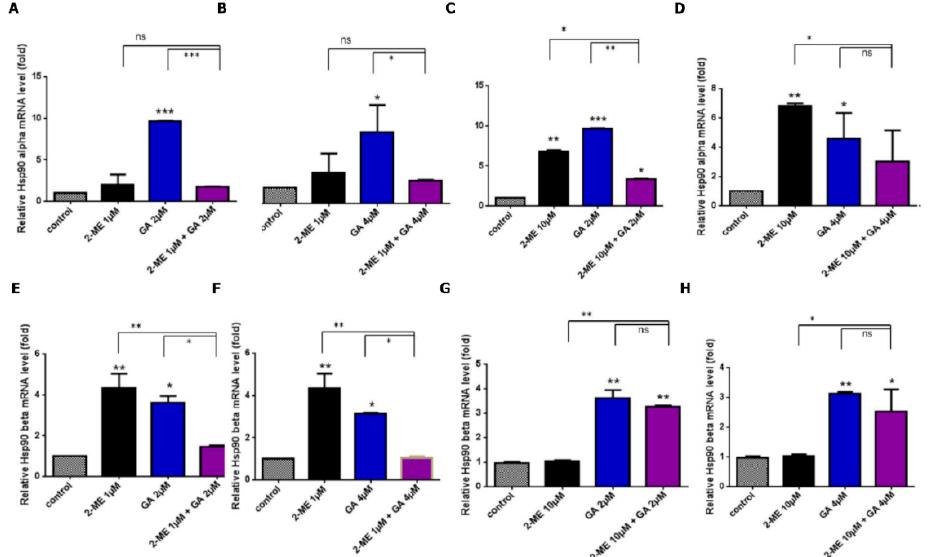
Figure 6. 2-ME and GA control the gene expression of Hsp90 alpha and Hsp90 beta in OS 143B cells. OS 143B cells were treated with either 2-ME (1 μ M or 10 μ M) or GA (2 μ M or 4 μ M) or in a combination of both for 8 h. Next, Hsp90 alpha ( A – D ) and Hsp90 beta ( E – H ) gene expression was determined by means of Real Time PCR. Data are presented as the mean ± SE values form at least three independent experiments. The absence of error bar denotes a line thickness greater than the error. Data were analyzed by GraphPad Prism Software version 6.02 performing one way ANOVA analyses followed by Tukey’s multiple comparison test. * p < 0.01, ** p < 0.001, *** p < 0.0001 versus control.